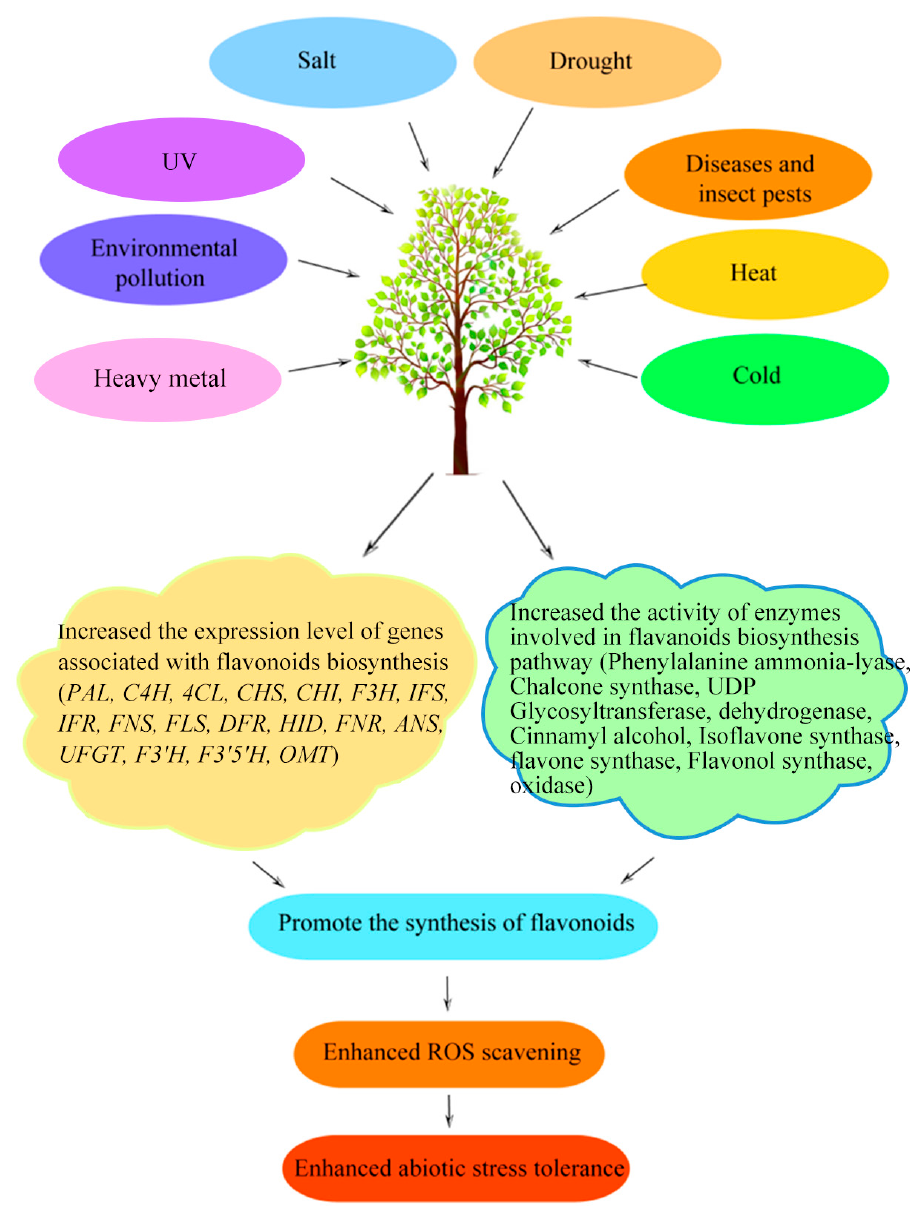
Figure 3. Molecular mechanisms of flavonoids in response to biotic and abiotic stresses.